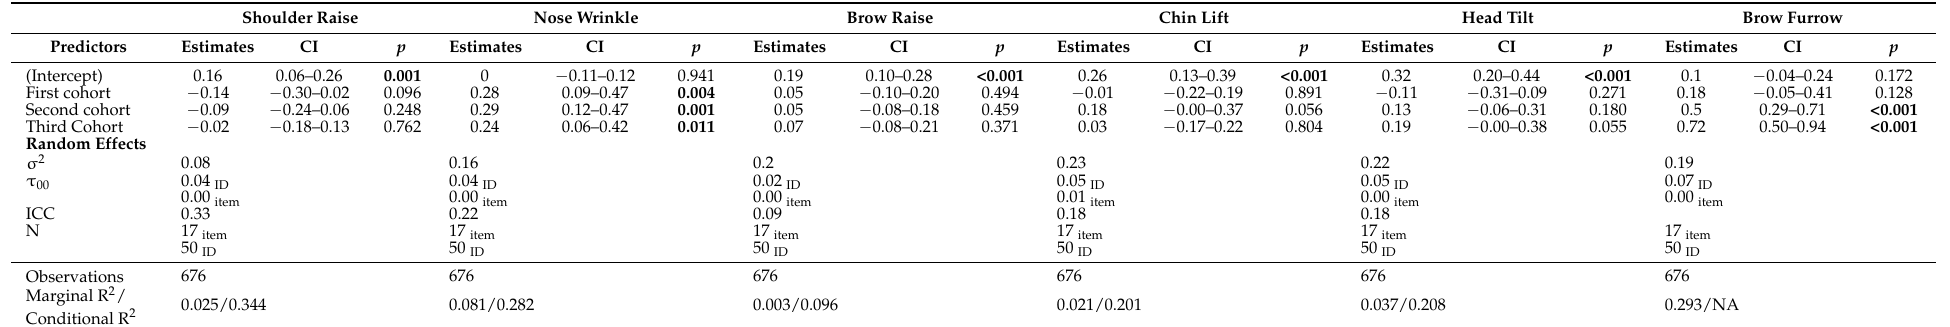
Table 5. Fixed and random effects predicting each nonmanual’s production. Table generated using the tab_model function from the SJPlot package version 2.6.2 for the R programming environment (Lüdecke